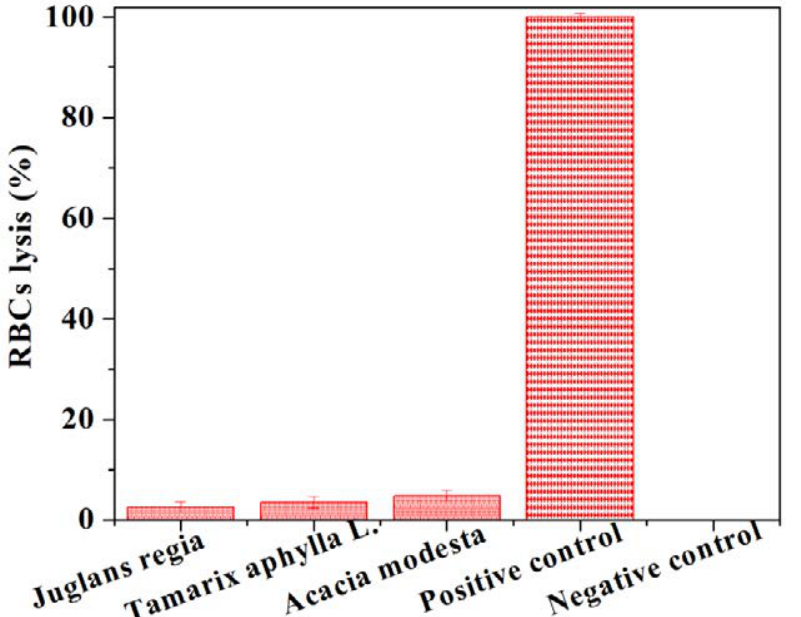
Fig. 4. Cytotoxicity assay by heamolytic activity of various plant extracts. Each bar is determinant of mean of three